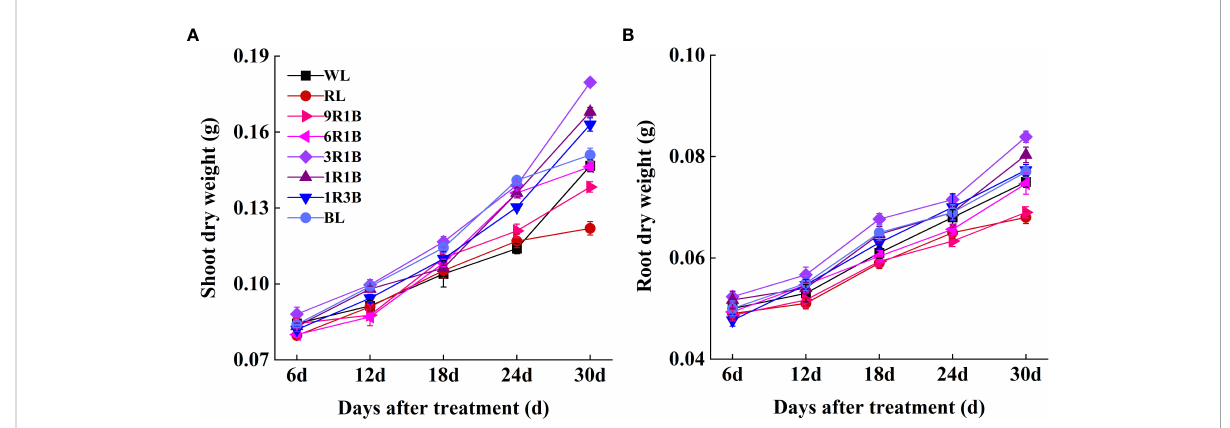
FIGURE 5 Effect of monochromatic and mixed red and blue light on (A) shoot dry weight and (B) root dry weight of sweet pepper seedlings throughout 30 days after